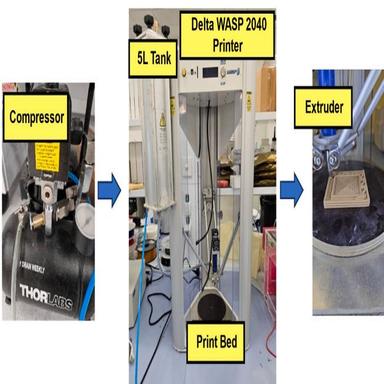
Schematic demonstrating 3DP setup.